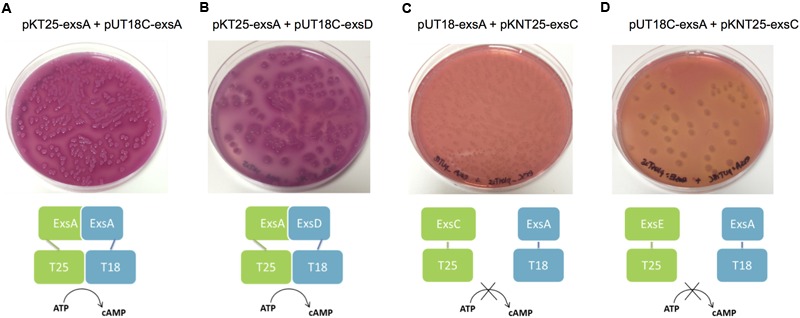
Illustration of BACTH interactions between ExsA and each of the Exs proteins. Plasmid combinations were co-transformed into E. coli BTH101 and grown on MacConkey-maltose agar for 2 days at 30°C. (A) pKT25-exsA with pUT18C-exsA showing strong ExsA–ExsA self-interaction (B), pKT25-exsA with pUT18C-exsD showing strong ExsA–ExsD interaction; (C), pUT18-exsA with pKNT25-exsC showing no interaction between ExsA and ExsC; (D), pUT18C-exsA with pKNT25-exsE showing no interaction between ExsA and ExsE. The BACTH assay was carried out three times for each combination.